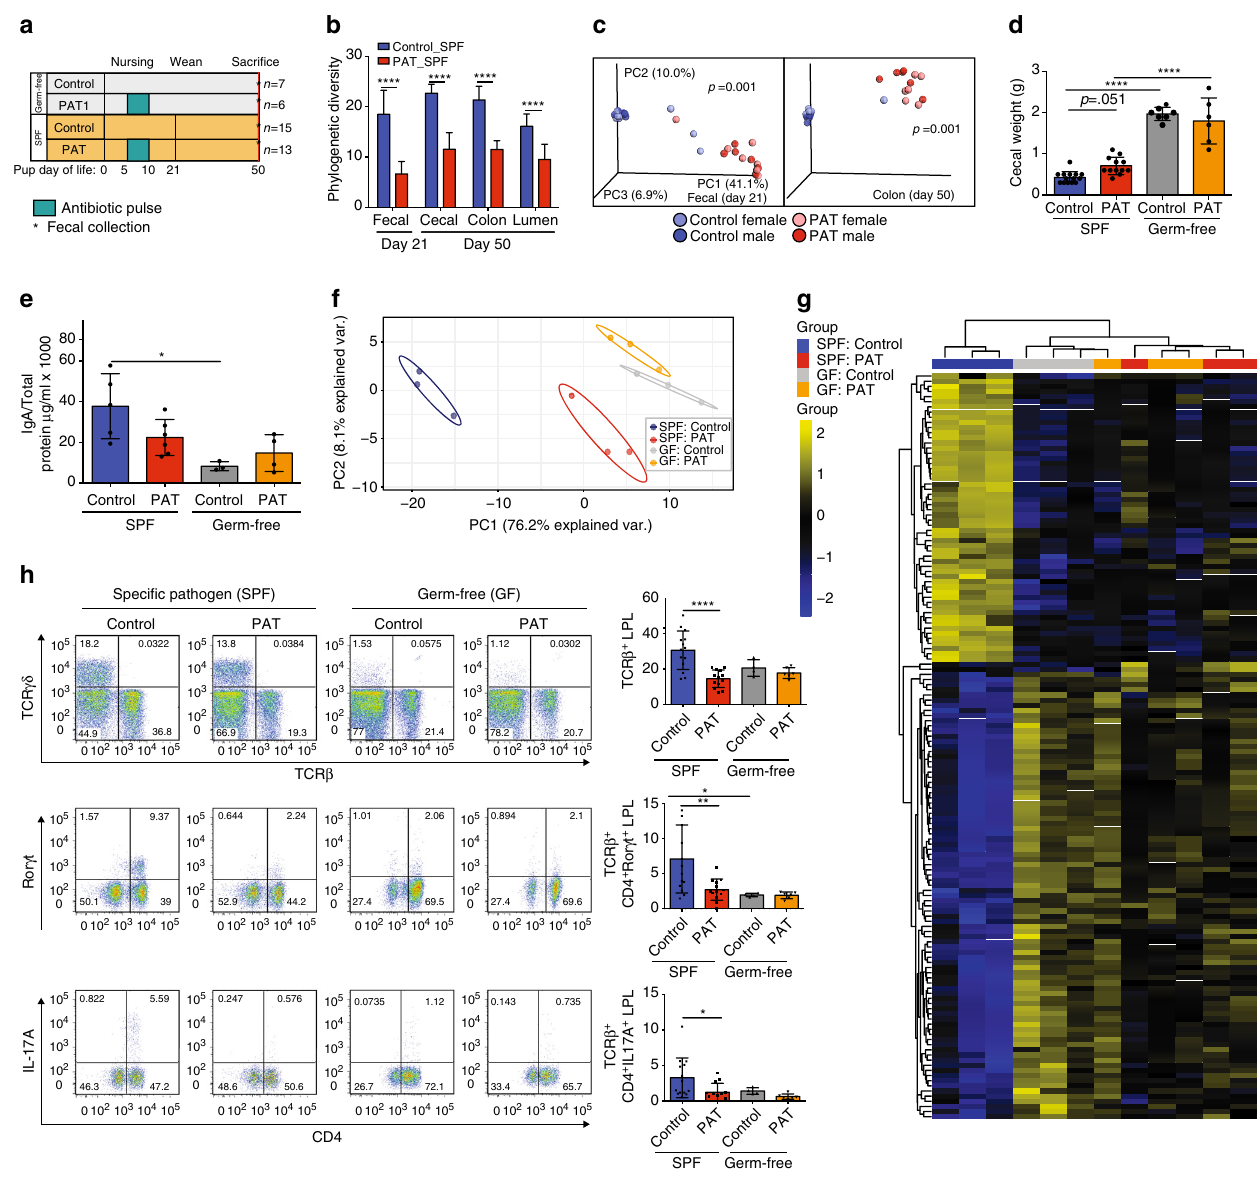
Fig. 3 Physiologic effects of PAT in germ-free and conventional speci fi c pathogen-free mice. a Study design: Germ-free (GF) and Speci fi c pathogen-free (SPF) C57BL/6 mice were treated with one course of tylosin on P5 for 5 days; SPF mice (control ( n = 15), PAT ( n = 13)), GF mice (control ( n = 7)), (PAT ( n = 6)). All mice were sacri fi ced at P50. b Mean ( ± SD) unrari fi ed α -diversity using the phylogenetic diversity (PD) metric of fecal samples at P21 and cecal and luminal contents at P50 in control and PAT SPF mice. Statistical analysis performed using two-sample t -test with Monte Carlo permutations, for statistical signi fi cance, see Supplementary Table 1. c Unweighted UniFrac analysis of fecal specimens in male ( darker circles ) and female ( lighter circles ) PAT or control SPF mice, depicted by principal coordinate analysis (PCoA). The three components explain 58% in total variance. Statistical analysis performed using an Adonis test, p = 0.001. d Aggregate cecal size in SPF and GF mice at P50 (mean ( ± SD)). e Secretory IgA (mean ( ± SD)) in luminal contents of offspring at P50, SPF mice (control ( n = 5), PAT ( n = 6), GF mice (control ( n = 3), PAT ( n = 4)). f PCoA of differential gene expression pro fi les in GF and SPF Control and PAT-exposed groups, with 76.2 and 8.1 % of the variance represented in PC1 and PC2, respectively. g Heat map of unsupervised hierarchal clustering of differential ileal gene expression pro fi les. After one-way ANOVA, Tukey HSD multiple comparison testing and FDR-correction, 145 genes were differentially expressed either between control vs PAT SPF, or GF vs SPF control groups ( n = 3/group). h Frequency of small intestine lamina propria lymphocyte (LPL) populations in PAT-treated GF and SPF mice (mean ( ± SD)). Intestinal LPLs were isolated from offspring at sacri fi ce. Representative fl ow cytometry plots were gated on live TCR β + cells, with frequencies of TCR β + , IL17A + CD4 + , and Ror γ t + CD4 + cells shown. Data are compiled from two experiments. Statistical analysis performed using the Kruskal – Wallis non-parametric test with Dunnett ’ s multiple comparisons test. For all panels: * p < 0.05, ** p < 0.01, **** p <